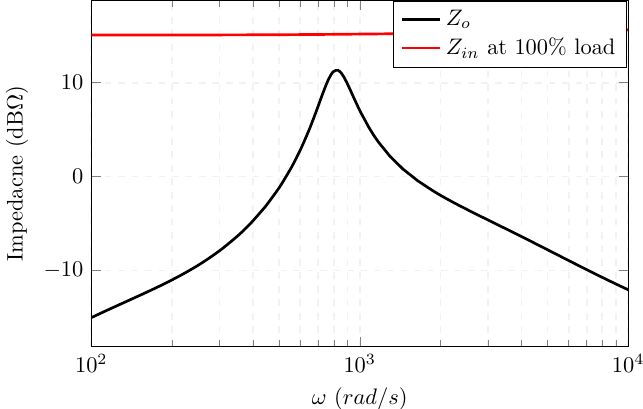
Figure 20. Impedance interaction decoupling between the boost and the buck converters using the proposed method.